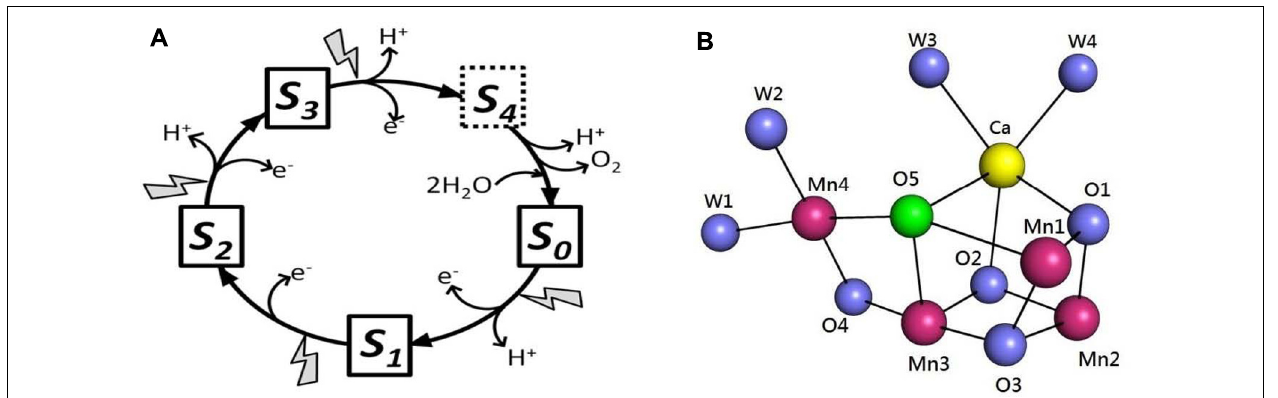
FIGURE 1 | (A) S-state cycle of photosynthetic water oxidation. (B) Structure of the Mn 4 CaO 5 cluster as revealed by the 1.9 Å XRD study (Umena etal., 2011). Images generated in the PyMOL program using Protein Data Bank entry 3ARC.